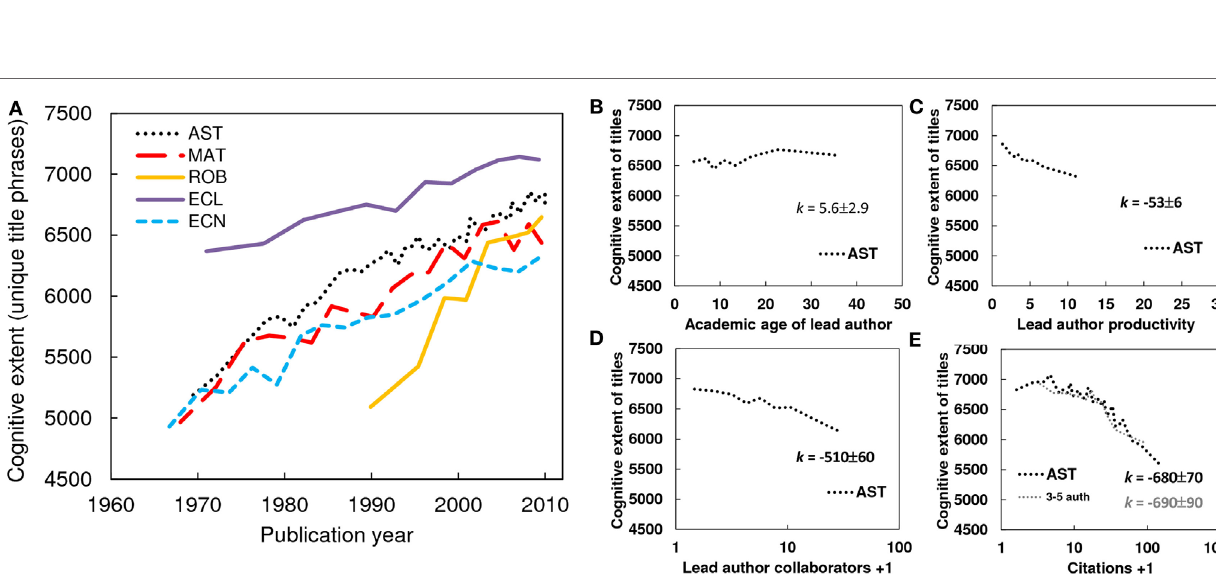
FigUre 4 | Trends involving declarative (or informative) titles . (a) Percentage of declarative titles for five disciplines [astronomy (AST), mathematics (MAT), robotics (ROB), ecology (ECL), and economics (ECN)] from 1961 to 2010. Percentage of titles containing active verbs for authors of different academic age (b) , productivity (c) , collaboration level (D) , and papers of different impact level (e)